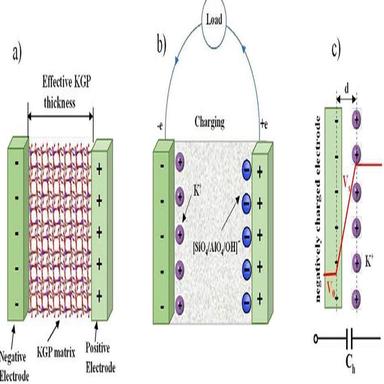
Energy storage mechanism in the KGP capacitors. a) KGP capacitor, b) charging mechanism, c) formation of a double layer capacitor